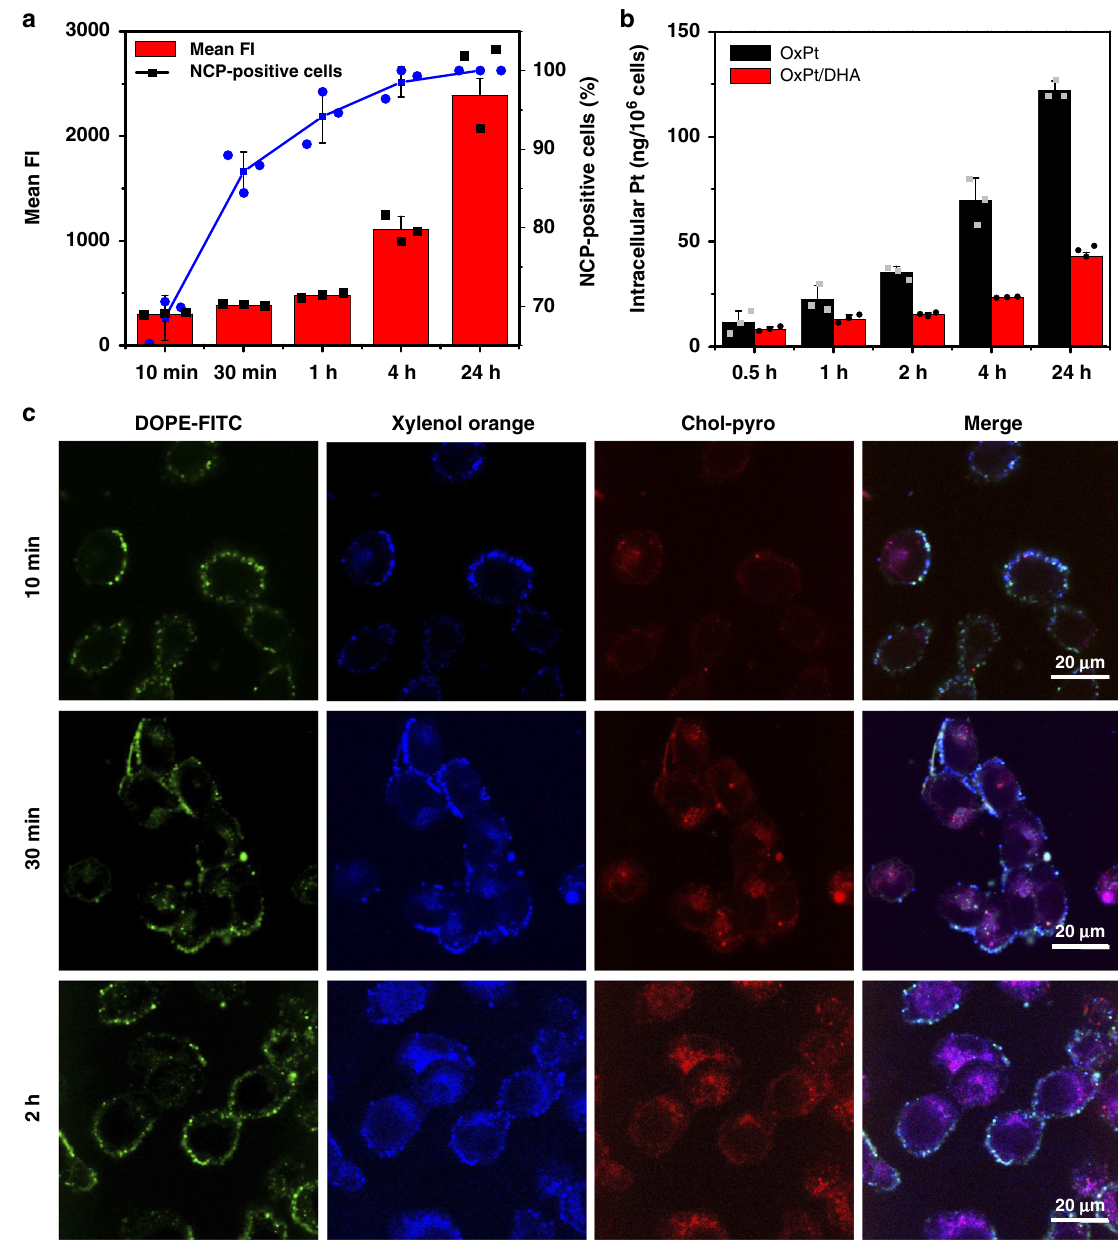
Fig. 2 Internalization and dissociation of NCP components in cells. a Uptake of chol-pyro-labelled NCP particles by CT26 cells at different incubation times. b The intracellular Pt in CT26 incubated with OxPt or OxPt/DHA as determined by ICP-MS. c CT26 cells incubated with fl uorescent nanoparticles containing xylenol orange in the core, chol-pyro in the shell, and FITC-DOPE lipid to visualize OxPt in the core, chol-DHA in the shell, and the lipid layer of OxPt/DHA, respectively, for different times were observed under confocal laser scanning microscopy (CLSM). The experiments were done three times and data were expressed as mean ± SD in ( a ) and ( b ). The images in ( c ) were obtained without repetition. NCP nanoscale coordination polymer, OxPt oxaliplatin, DHA dihydroartemisinin, ICP-MS inductively coupled plasma-mass